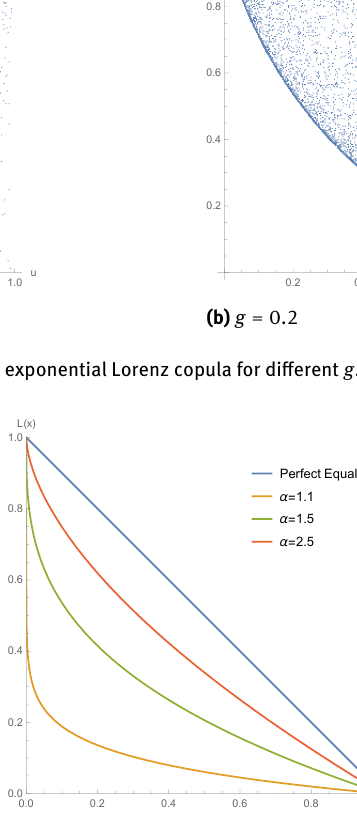
Figure 9: Examples of Pareto generators for different values of α .